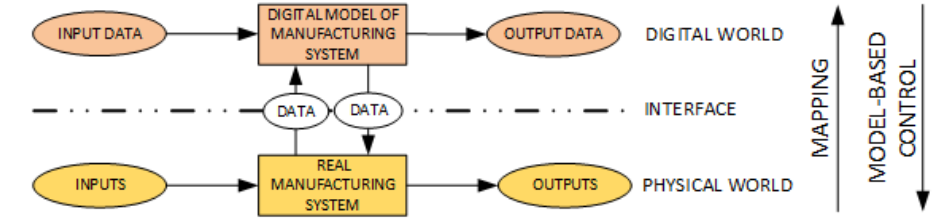
Figure 1. Connections between a real manufacturing system and its digital model.